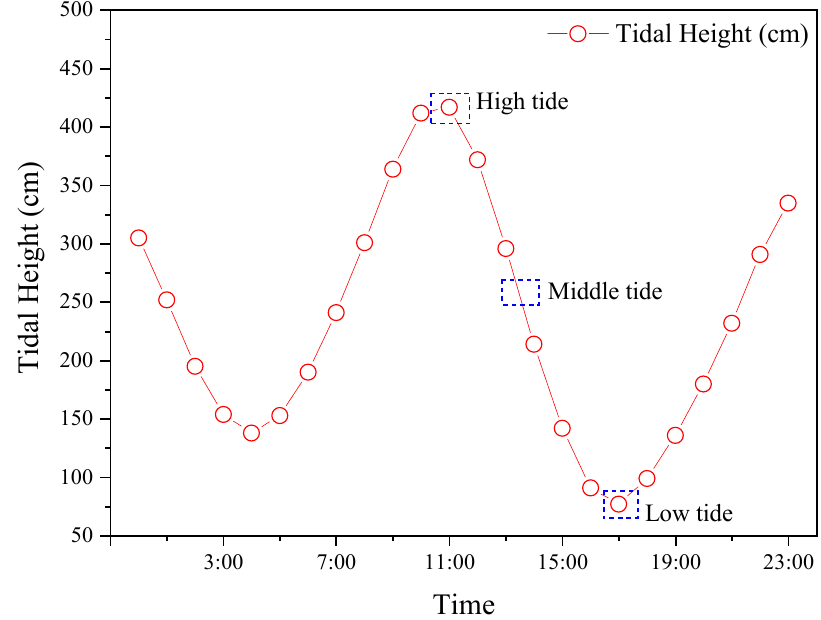
Figure 2. Tidal variations in ZJB coastal water during the investigation period.